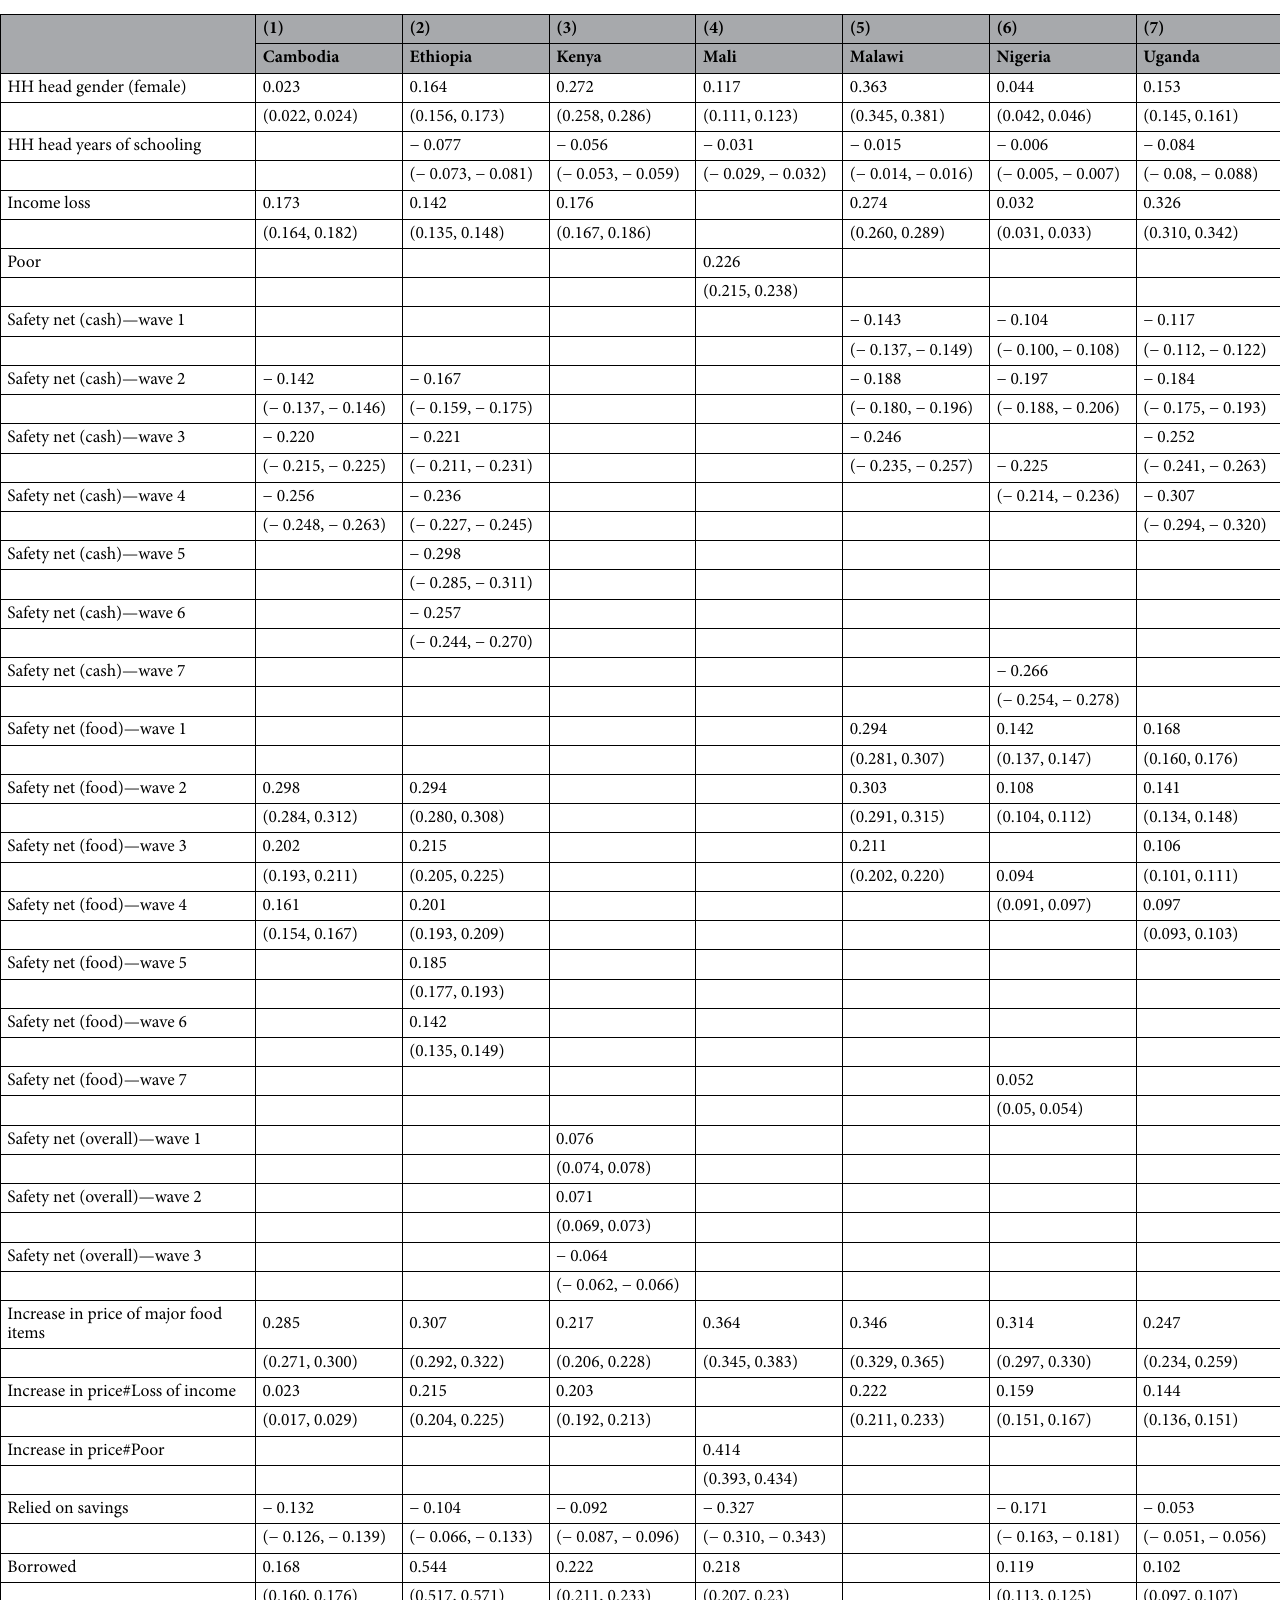
Table 2. Determinants of food insecurity—skipped a meal. 95% CI in